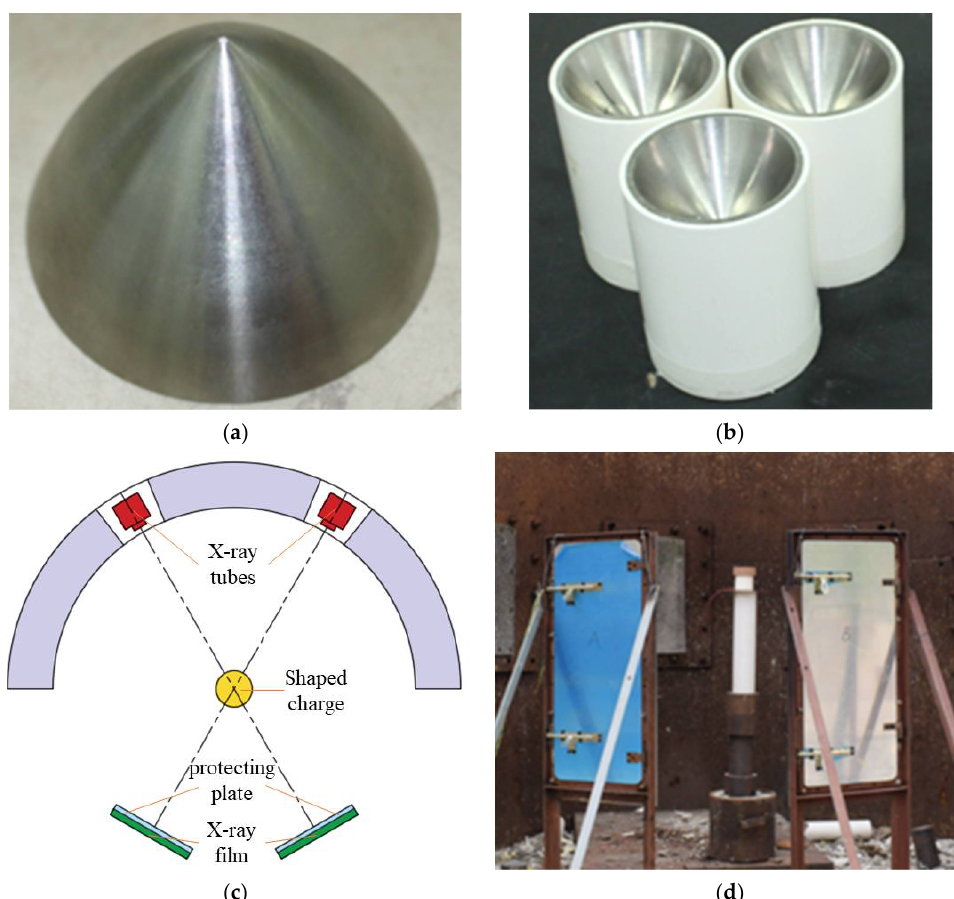
Figure 1. Experimental principle and setup of pulse X-ray. ( a ) Titanium alloy liner; ( b ) shaped charge structure; ( c ) schematic; ( d ) test setup.